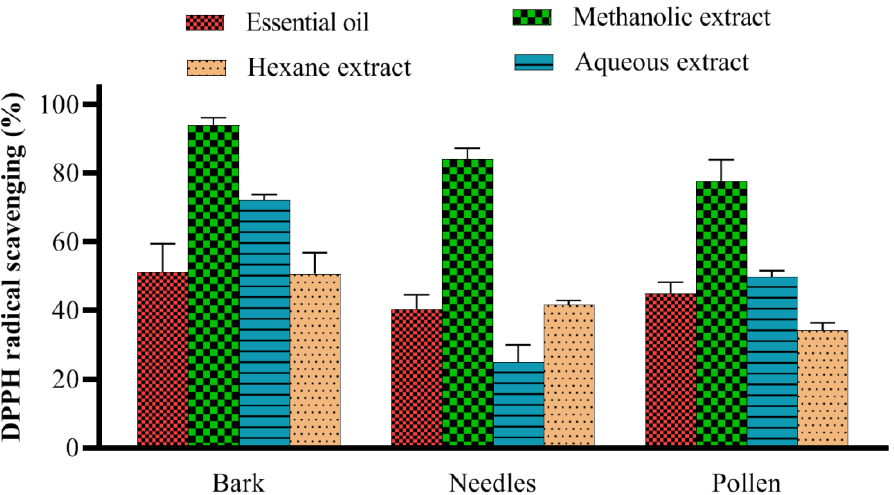
Figure 1. DPPH radical scavenging (%) of the four different extracts (hexane, methanolic, aqueous extracts, and essential oils (each 1 mg/mL)) prepared from the Pinus eldarica bark, needles, and pollen. Data are expressed as mean ± standard deviation (SD), representative of three independent experiments.